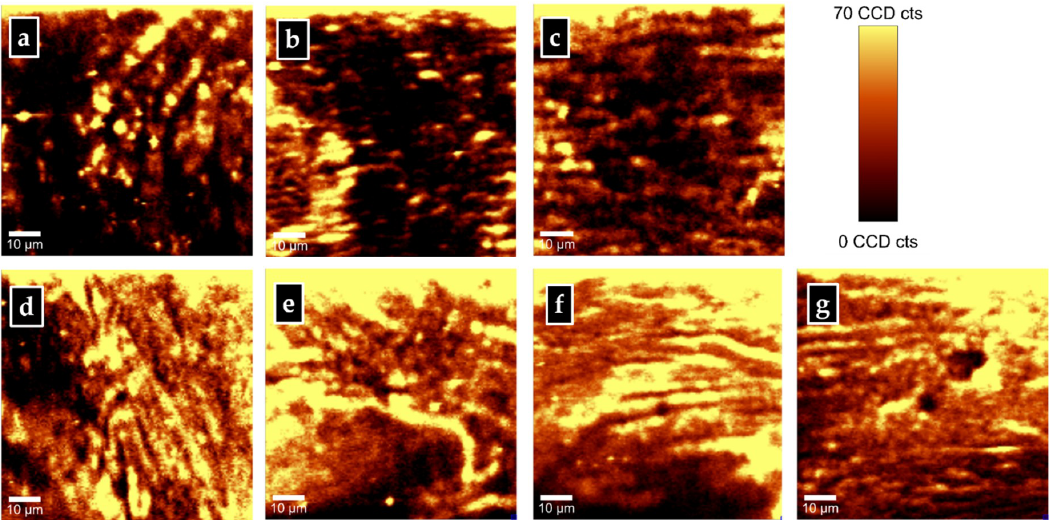
Figure 2. Representative confocal Raman images of phenylalanine content in: ( a – c ) normal bone samples and ( d – g ) ROD samples. A bright yellow pseudo-color corresponds to a higher Raman intensity.